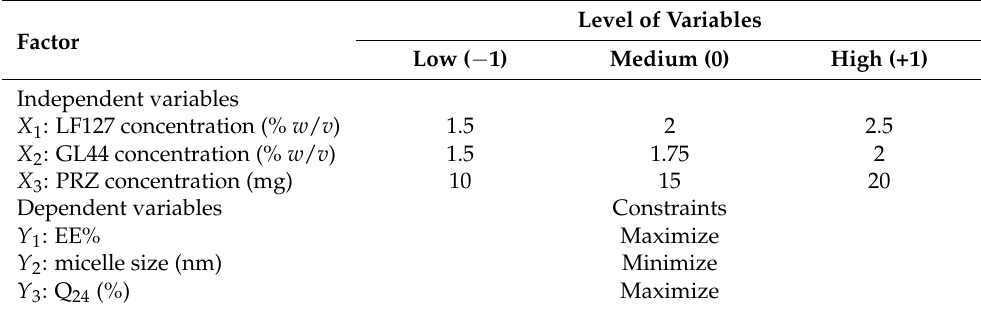
Table 1. Variables of Box-Behnken design for PRZ-PMMs